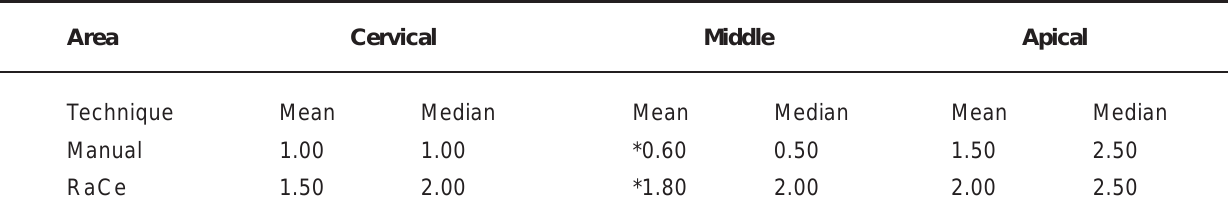
TABLE 1- Arithmetic mean and median of the scores obtained by visual evaluation of the amount of remaining dye inside the root canals